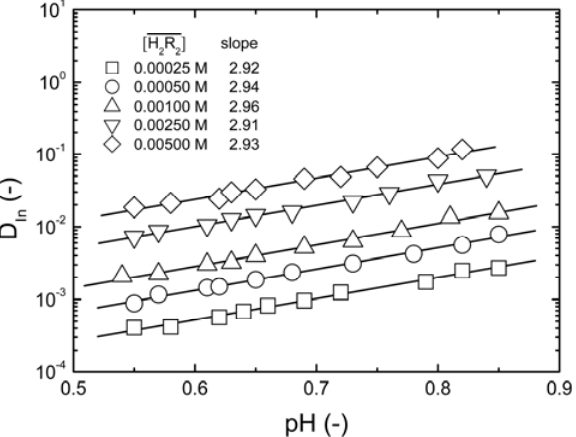
vs. pH at equilibrium with various D2EHPA In = 0.020 to 0.15 kmol/m 3 t